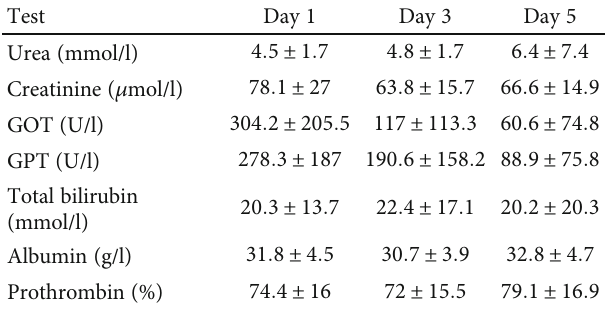
Table 4: Biochemical and coagulation indices 1, 3, and 5 days after surgery.